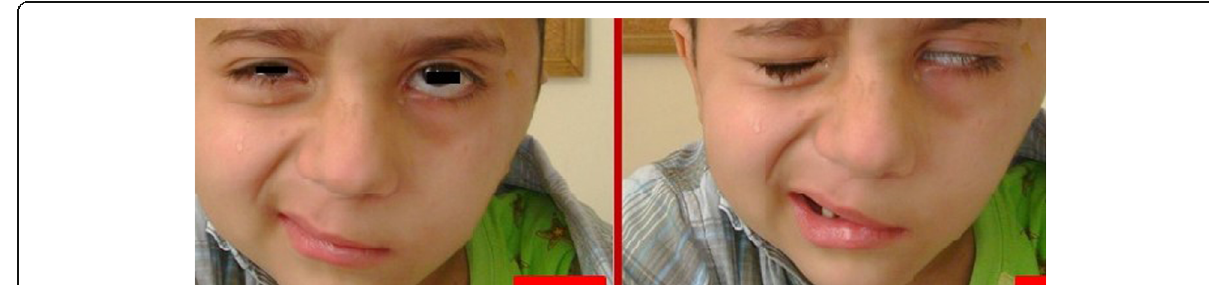
Fig. 1 Left grade 5 facial paralysis according to the House-Brackmann grading system